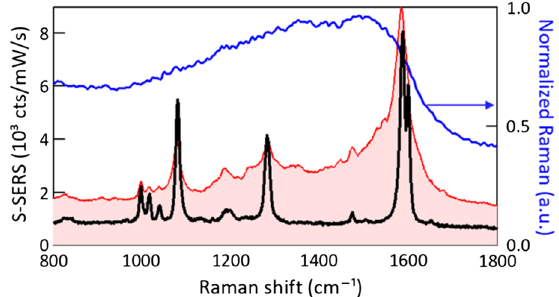
FIG. 10. SERS spectra from a single 80-nm gold nanoparticle- on-mirror for a CW 633-nm low-power I ¼ 260 μ W = μ m 2 (black curve) and high-power I ¼ 1200 μ W = μ m 2 (red filled curve) excitation. Raman of a 1-nm-thick amorphous carbon layer on gold is also shown (blue line) as a comparison.